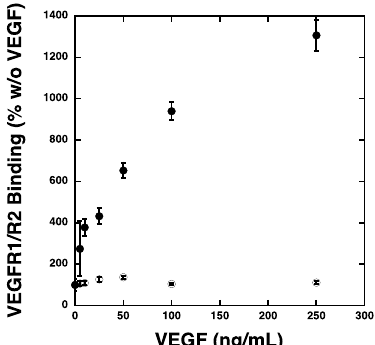
Figure 5. Fc-VEGFR2 binds to VEGF-Fn in a VEGF-Dependent manner. Fn (fibronectin) was adsorbed onto polystyrene plates overnight at 4 °C in the presence of heparin. The wells were washed to remove the heparin and incubated with the indicated VEGF concentrations. Unbound VEGF was removed prior to addition of 25 ng Fc-VEGFR1 (open circles) or Fc-VEGFR2 (closed circles) for 1 h at room temperature. The wells were washed and the Fc-chimera proteins were detected with HRP labeled goat anti human IgG. The absorbance values were determined in quadruplicate wells and the data is expressed as the average ( N = 4) percentage relative to the absorbance observed with each chimera when no VEGF was present (zero VEGF was set to 100% for each chimera) ± SEM.